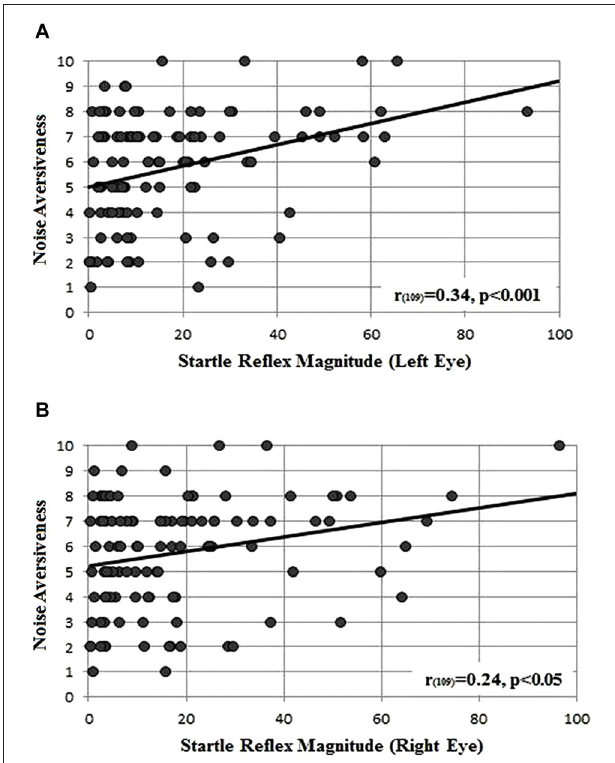
FIGURE 2 | Correlation between the startle reflex magnitude measured in microvolts, below the left (A) and (B) right eye and the perceived noise aversiveness (scale 0–10)